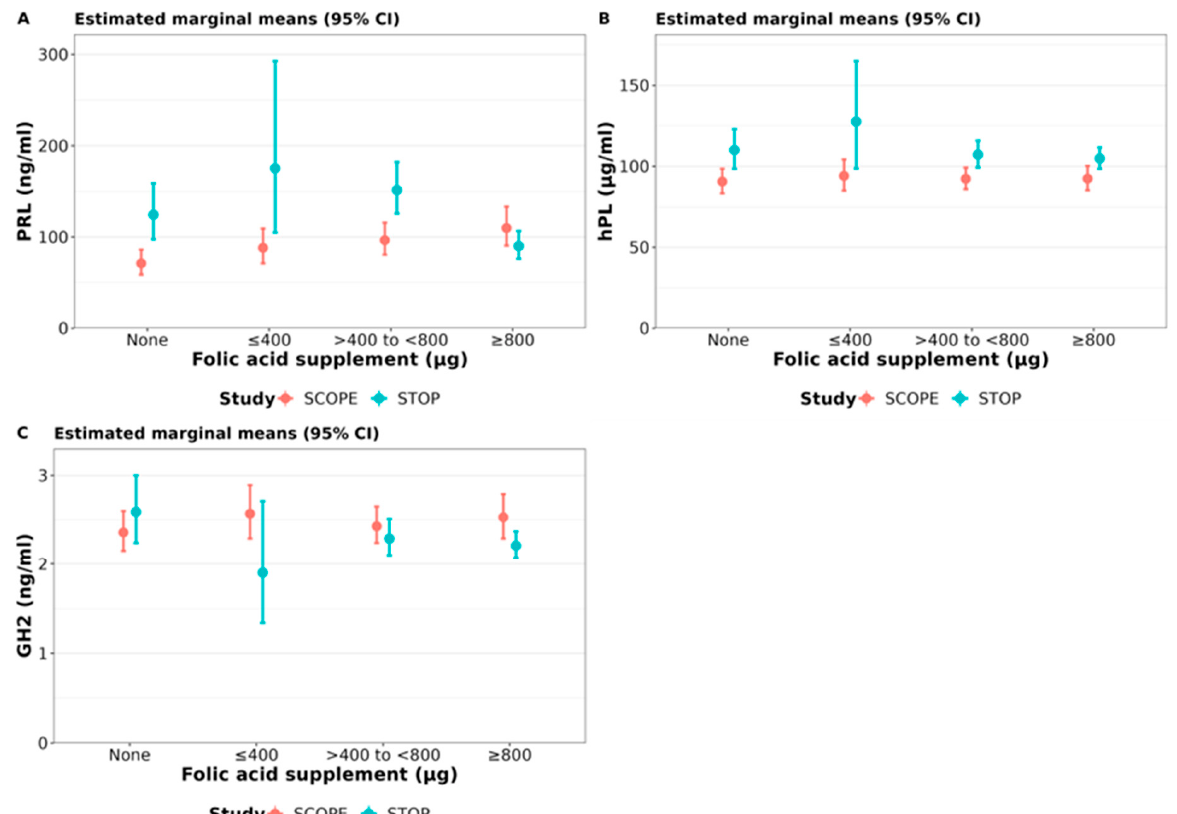
Figure 5. Serum hormone concentrations stratified by FA supplementation: Estimated marginal means for ( A ) prolactin (PRL), ( B ) human placental lactogen (hPL) and ( C ) placental growth hor- mone (GH2) in SCOPE (14–16 weeks of gestation) and STOP (6–16 weeks) women are stratified by four different FA supplementation categories (SCOPE N = 465; STOP N = 624).